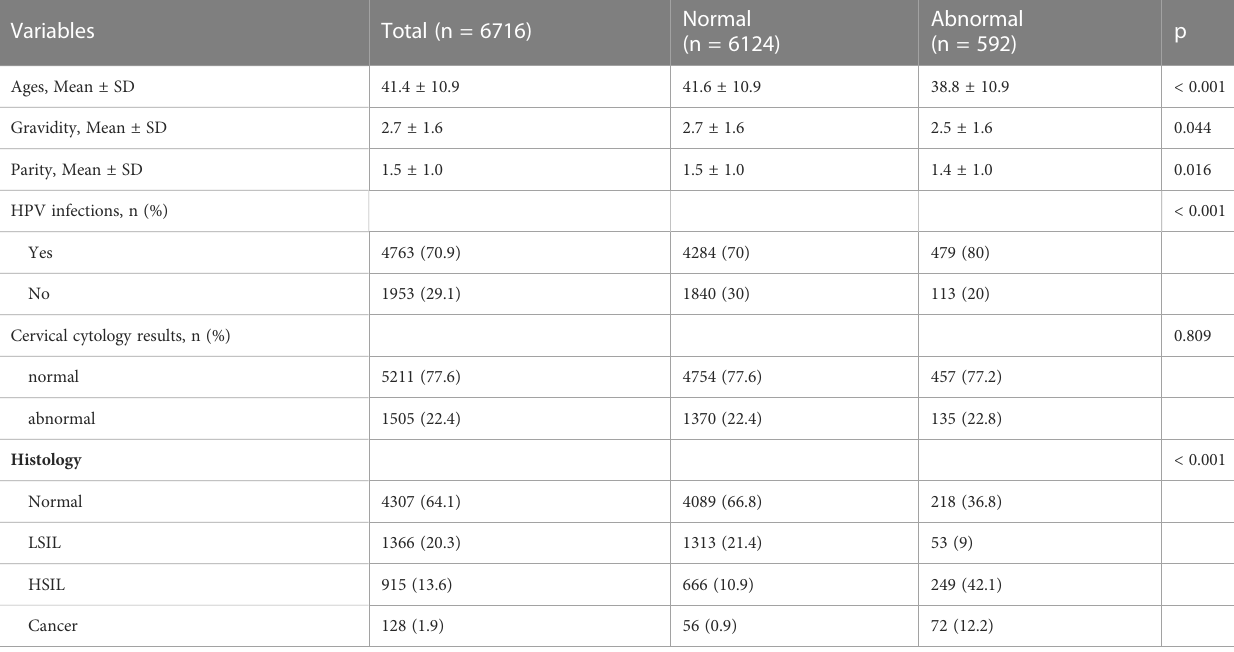
TABLE 1 Characteristics of the studied patient sample in cervical vascular normality group and cervical vascular abnormality